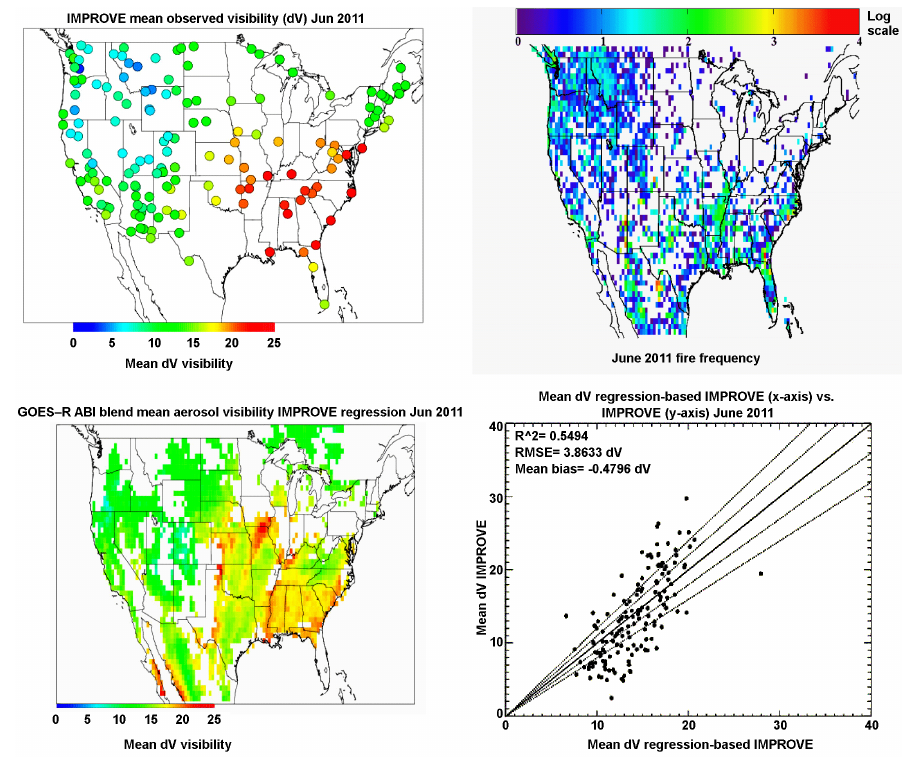
Figure 5. Top left panel: IMPROVE mean observed visibility (d V ) in the United States for June 2011; top right panel: WF-ABBA fire frequency in the United States for June 2011; bottom left panel: IMPROVE regression (bias-corrected) retrieval mean d V in the United States for June 2011; bottom right panel: scatter plot of collocated mean d V IMPROVE regression (bias-corrected) retrieval versus IMPROVE for all IMPROVE sites for June